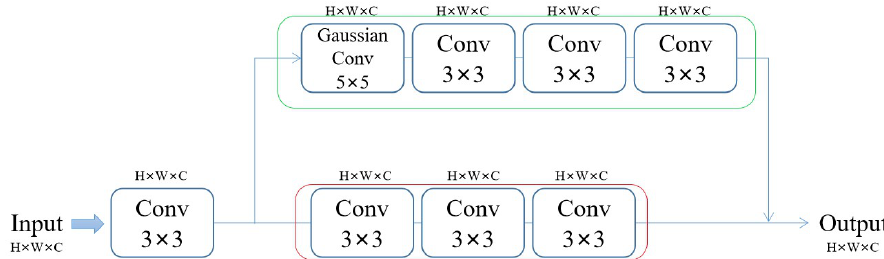
Figure 6. Shallow feature extraction network